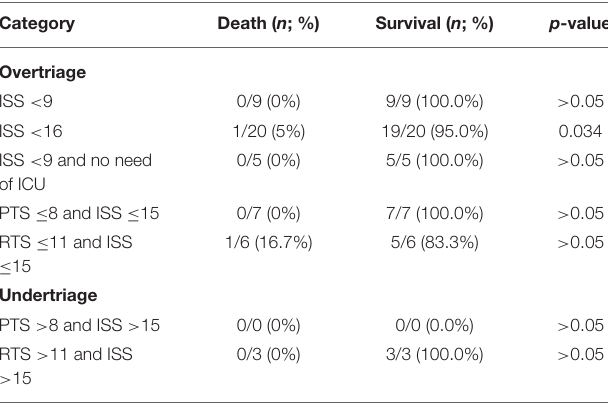
TABLE 2 | Distribution of overtriage and undertriage according to their different definitions and mortality in each group. Category Death ( n ; %) Survival ( n ; %) p